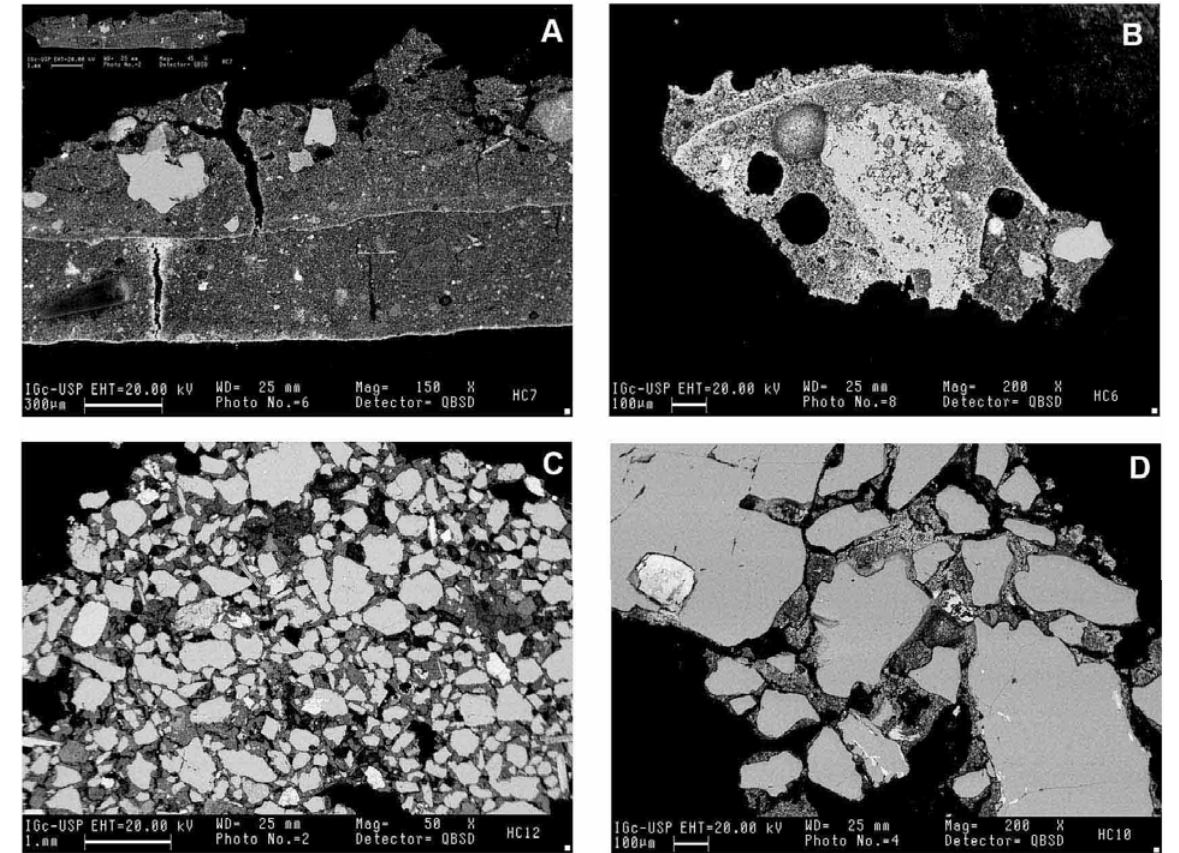
Fig. 2 – SEM images of distinct textures observed in the frescoes. A and B are texture type 2 . C and D are texture type 1 . Notice the very thin and continuous calcite layer in A and